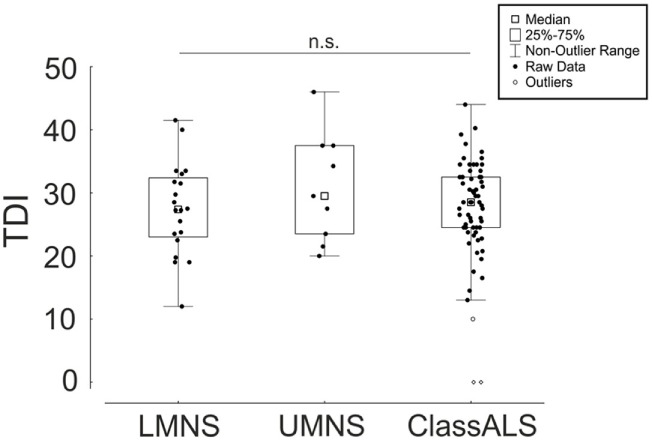
Comparison of the composite of the three subtests (TDI) between amyotrophic lateral sclerosis (ALS) patients with prominent lower motoneuron symptoms (LMNS), upper motoneuron symptoms (UMNS), and classical ALS with both symptoms (ClassALS). Box plots with single values (dots). Not significant (n.s.).